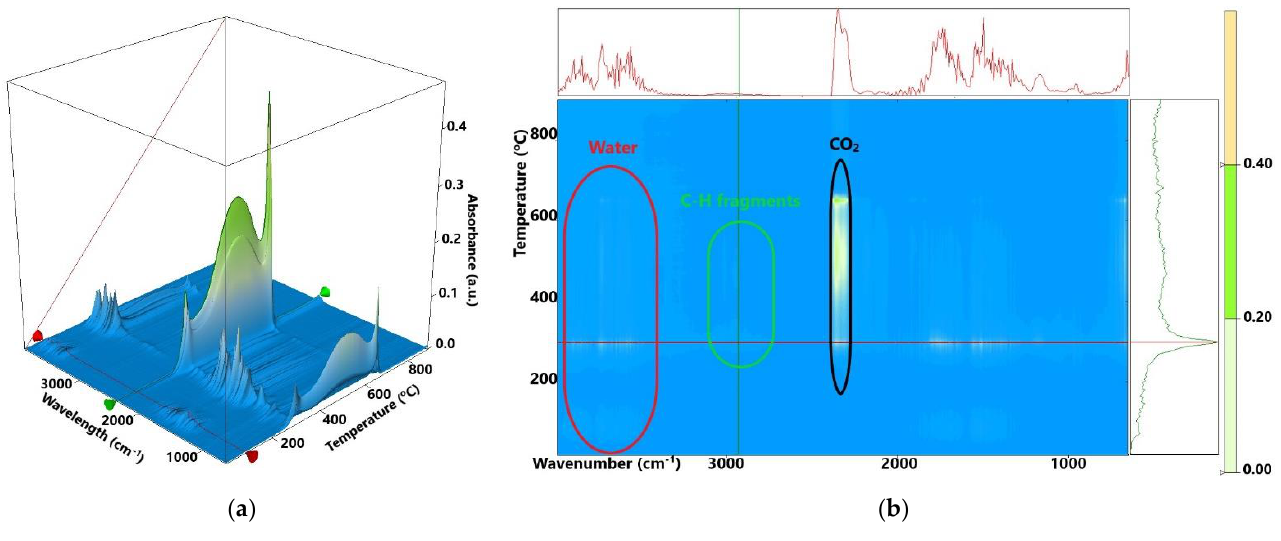
Figure 6. The evolved gases FTIR 3D diagram for the CS/TiO 2 5% sample ( a ) and its 2D projection with assigned identification/temperature zones ( b ); the yellow-green indicates the zones with high absorbance, while the light shade of blue corresponds to the zones with low absorbance.